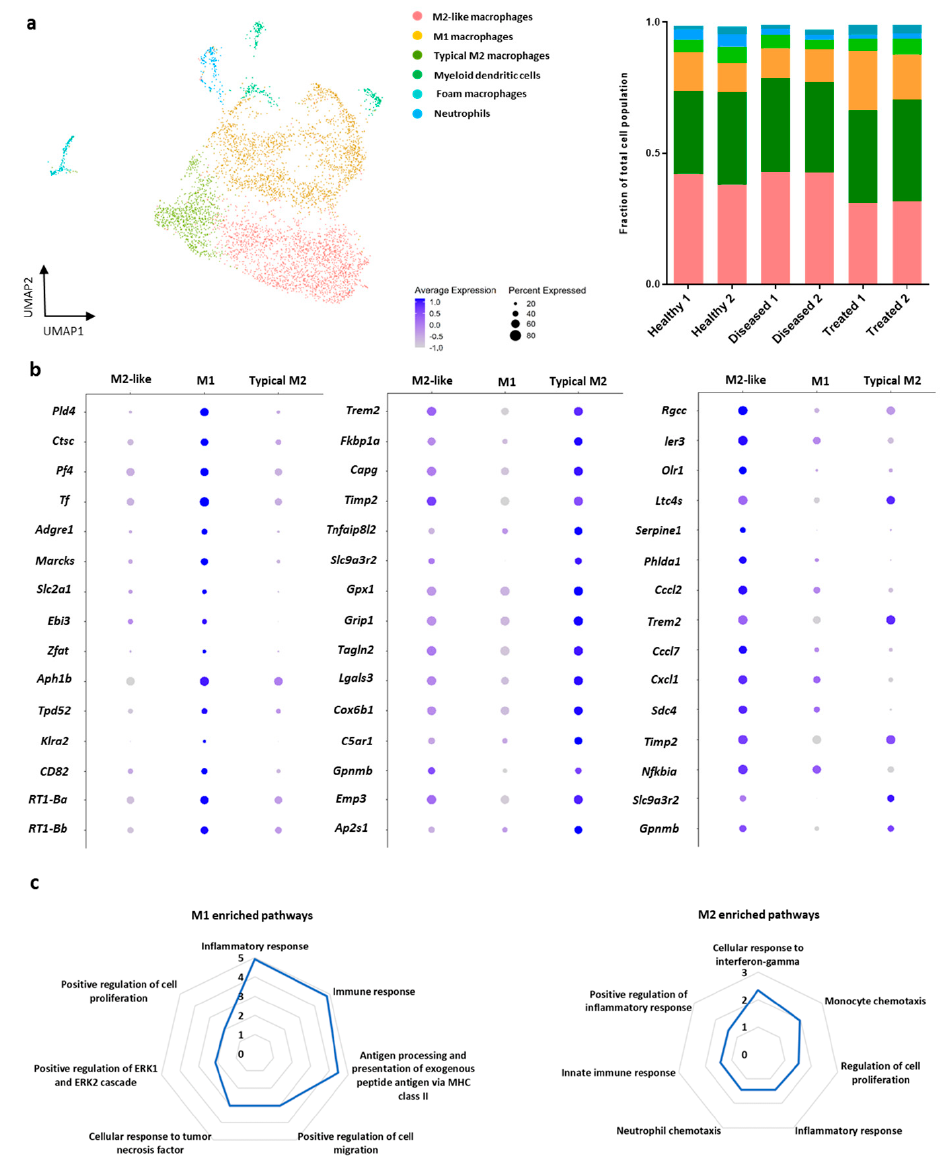
Figure 3. Single-cell transcriptional profile of the CD68 + myeloid cell population. ( a ) Six immune cell subsets were identified within the CD68 + cell cluster. Analysis of the marker genes for these clusters revealed three macrophages biological subtypes the M2-like macrophages, the M1 macrophages, and the typical M2 macrophages. Each point represents a single cell and separate subpopulations identi- fied were color-coded. Cell population proportion of typical M2 macrophages relative to M1 is lowest in the diseased samples, followed by healthy and treated. Cell population proportions per sample were visualized by stacked bars plot. ( b ) Dot plot representing gene expression for macrophage polarization marker genes in all three groups tested (healthy, diseased, treated). ( c ) Enriched path- ways of genes identified in M1 and M2 macrophages subclusters. Pathway analysis revealed highly enriched genes in M2 and M2-like subpopulations mostly involved in immunoregulatory pathways. In contrast, M1 enriched genes were involved in antigen processing and presentation, and cellular response to TNF/IFN γ